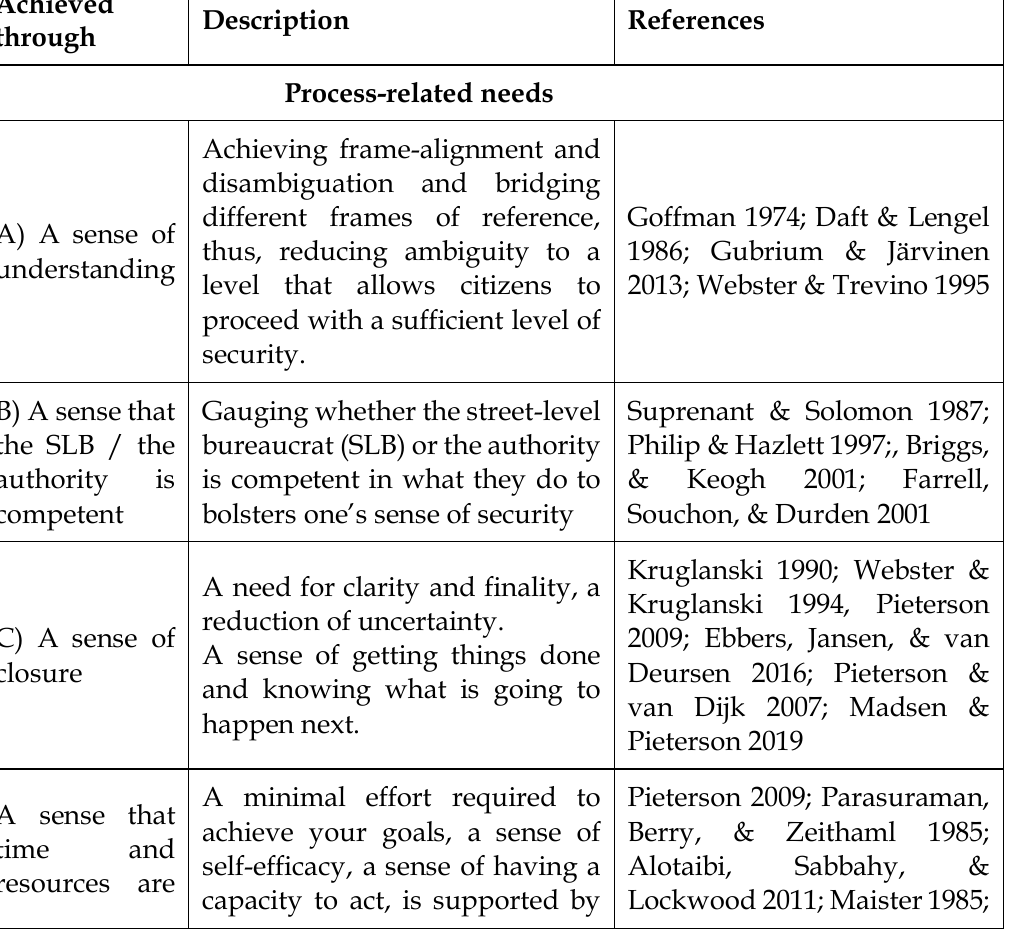
Table 2: Framework of needs and goals